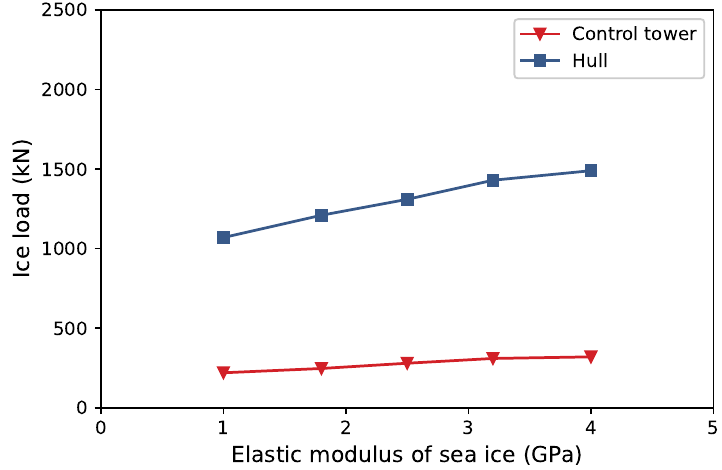
Figure 11. The relation curve between submarine ice load and sea ice elastic modulus.